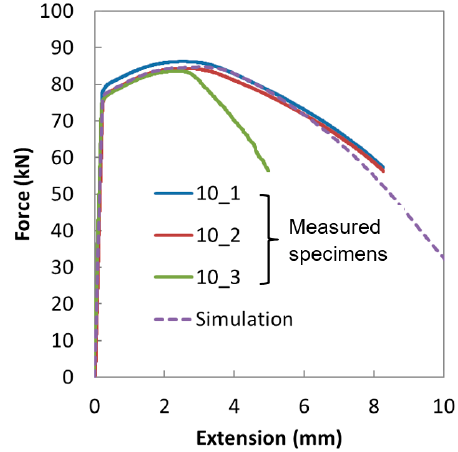
Figure 16. Comparison of tensile test curves.